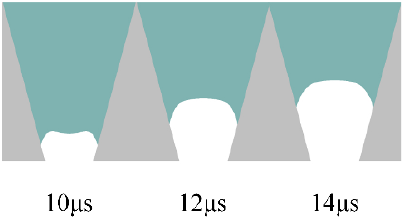
Figure 4. Excessive ink is sucked into the nozzle when the t r is 1 µs.